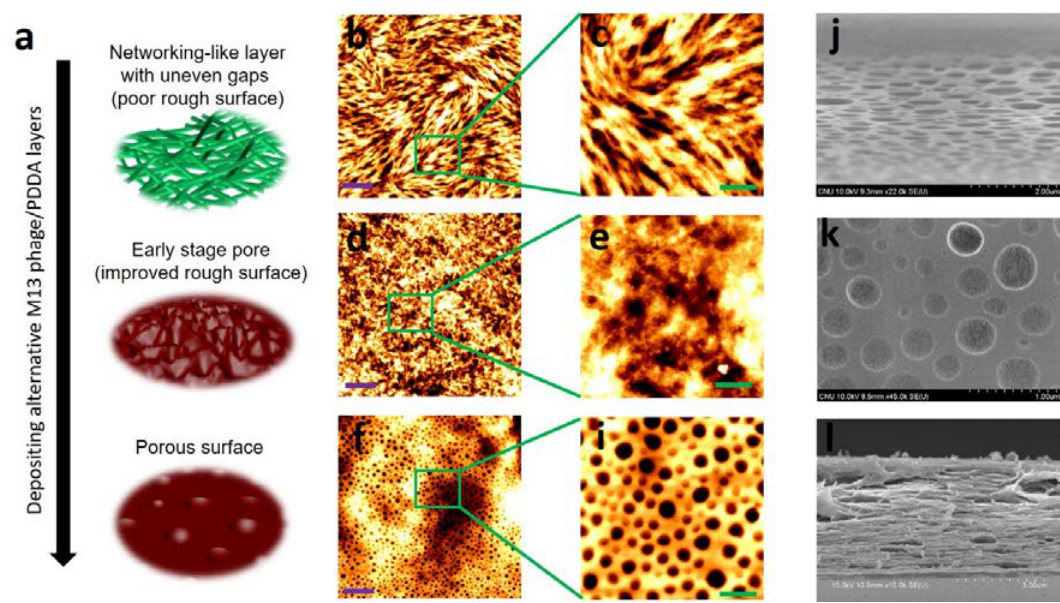
Figure 2. ( a ) Fabrication of porous surfaces by depositing M13 phage and PDDA layers in an alternating manner originating from a randomly distributed network-like structure. ( b , c ) AFM images of first layer, ( d , e ) sixth layer, and ( f , i ) 10th layer surfaces. Violet and green scale bar colors represent five and one µm, respectively. Scanning electron microscopy (SEM) images taken from a 10-layer biofilm: ( j ) perspective view, ( k ) top view, and ( l ) cross-sectional view. Scale bars for ( j – l ) are two, one, and three µm, respectively. The cracks shown in figure ( k ) were caused by platinum coating for SEM analysis.